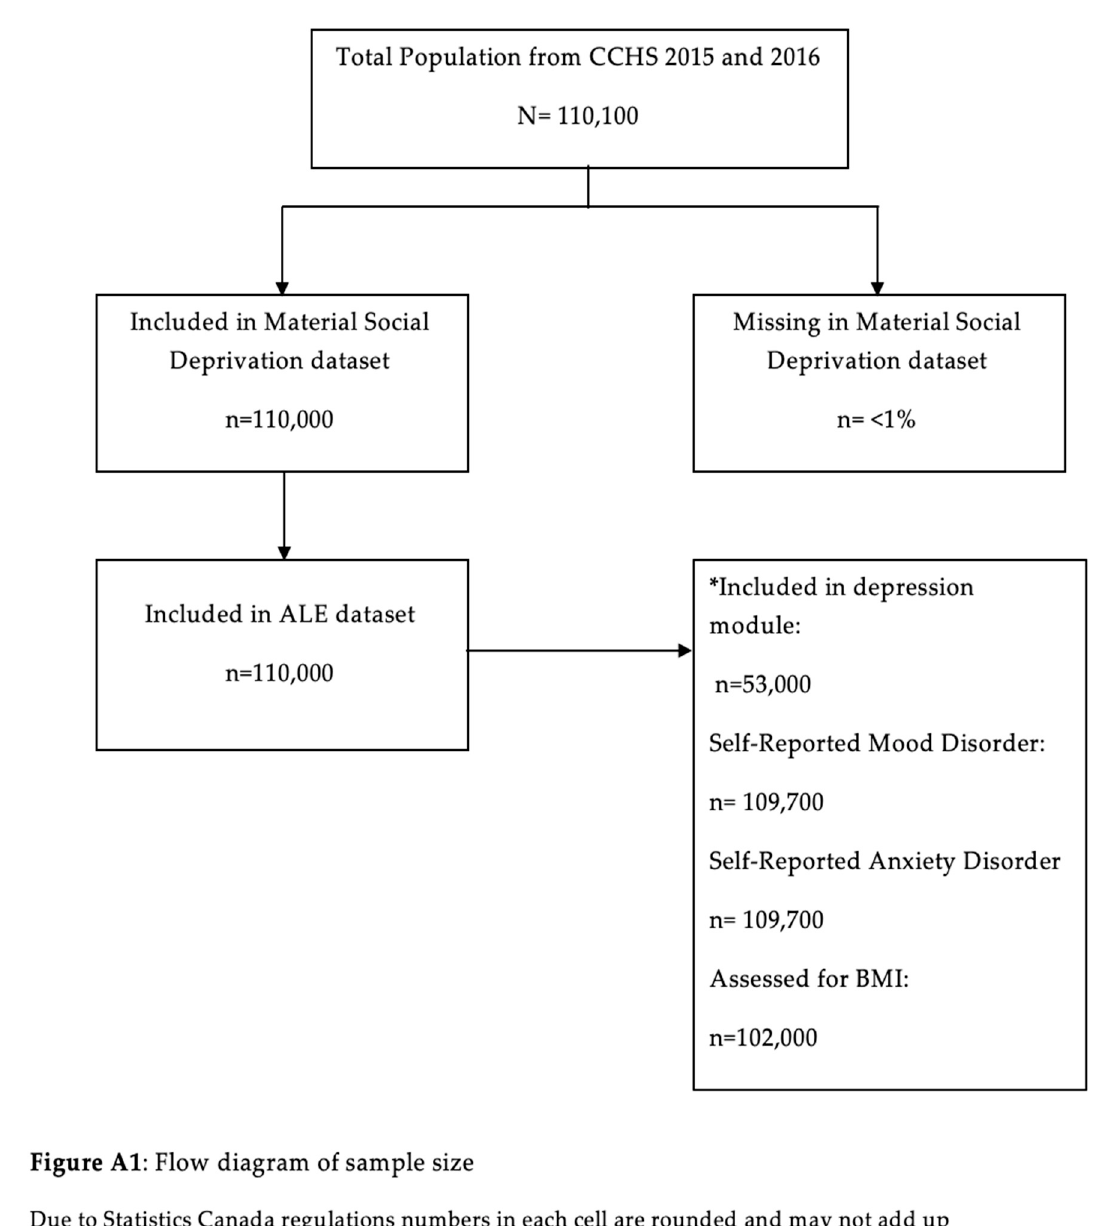
Figure A1. Flow diagram of sample size.